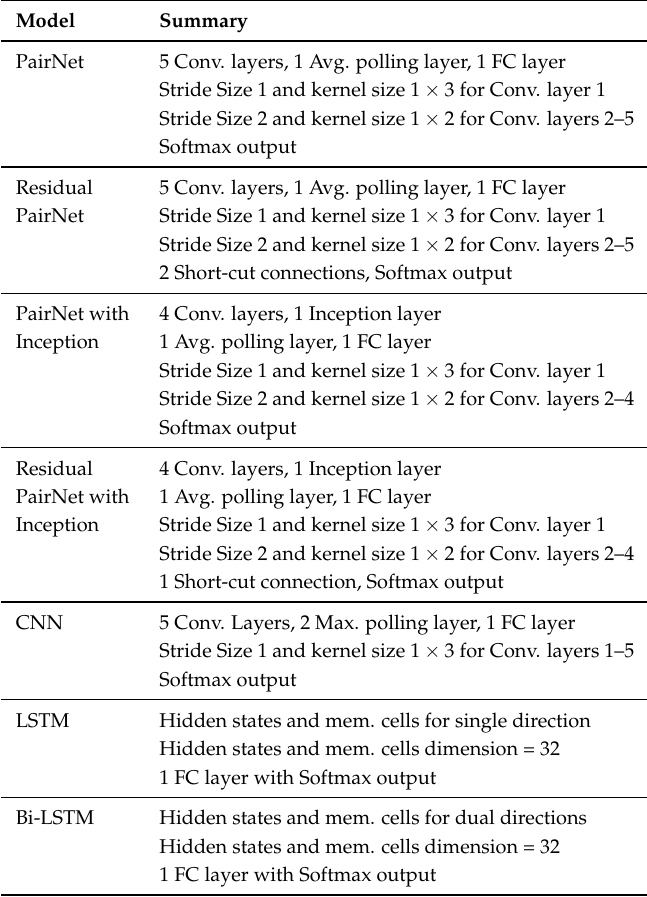
Table 3. The model summary of various